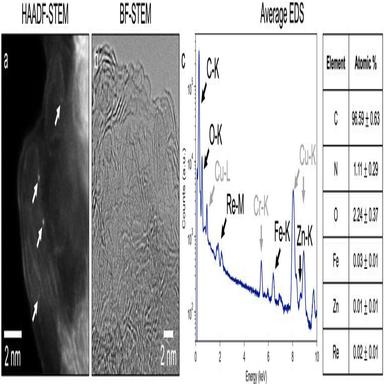
STEM characterization of the FeReNC material. (a) HAADF-STEM shows the presence of both lighter and heavier metal atoms (arrows). (b) BF-STEM shows the carbon support is a few-layered crumpled graphitic material. (c) Average EDS measurements of the material confirm the presence of Re and Fe, as well as a Zn, which can be a residual of common SAE synthesis methods. Background EDS peaks originating from the sample holder are labeled in gray.